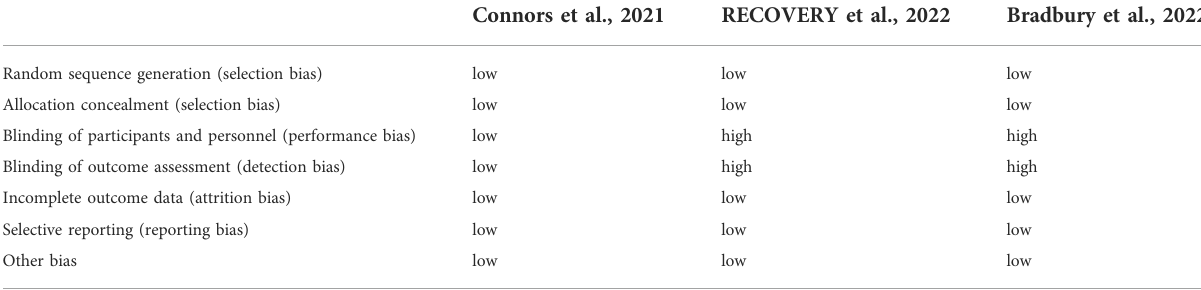
TABLE 2 The qualities of randomized controlled trials assessed by Cochrane Risk of Bias Assessment